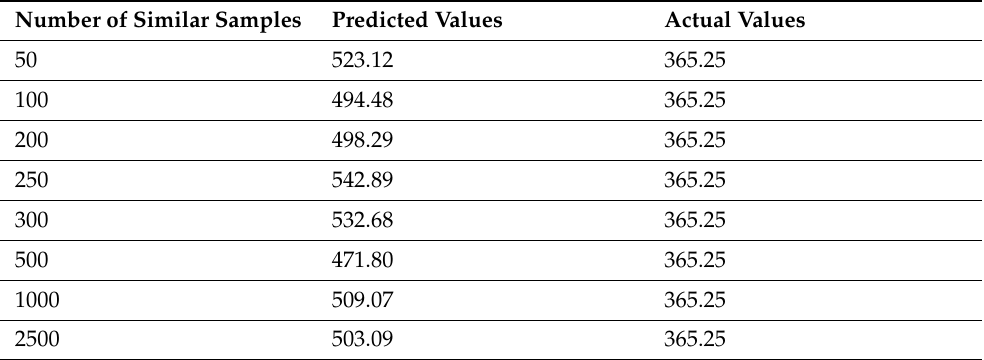
Table 14. Results for experimental unit conversion approach with two common traits matched from previous methods and 100 steps depending on the number of similar